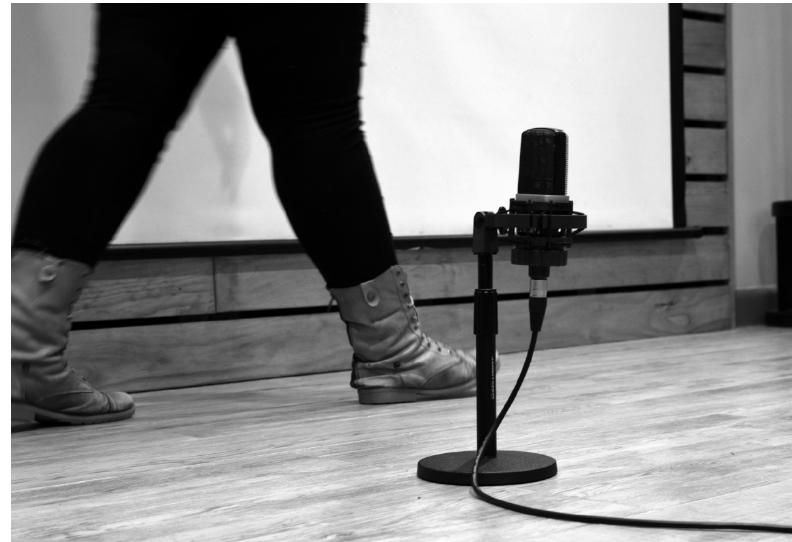
Figure 1. Illustration of the recording